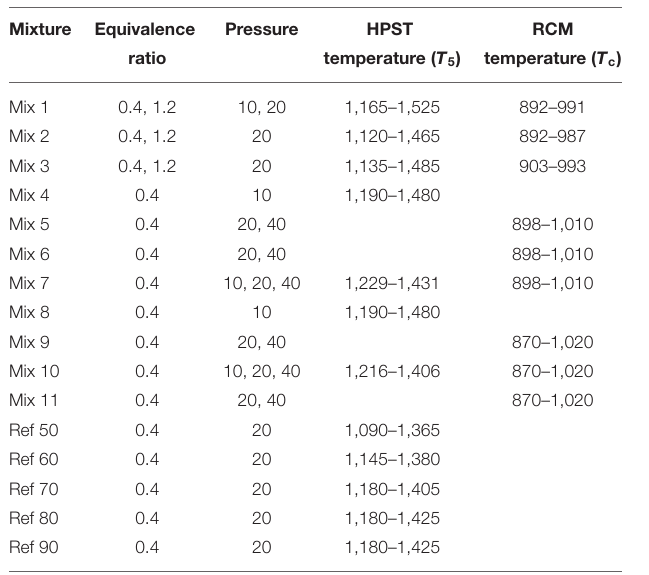
TABLE 2 | Details of the experimental conditions investigated in this work.